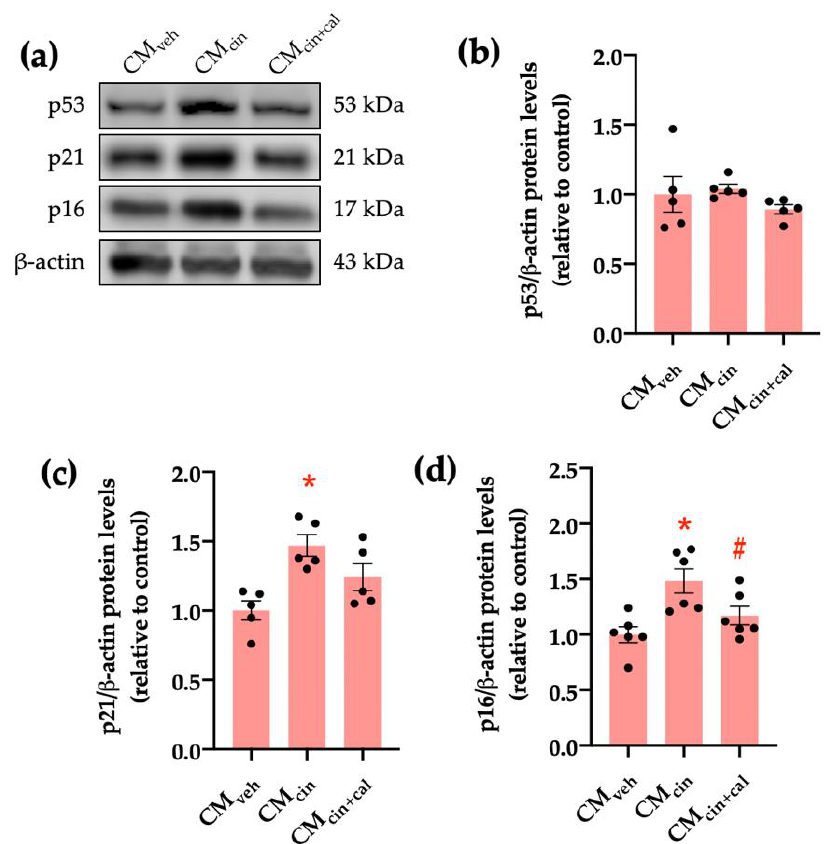
Figure 2. CaSR activation in SW872 pre-adipocytes induces the secretion of factors that activate the p16/p21/p53 cascade in HepG2 cells: ( a ) immunodetection of p53, p21, and p16 protein levels in HepG2 cells exposed to the CM veh , CM cin , and CM cin+cal ; ( b ) quantification of p53 protein levels; ( c ) quantification of p21 protein levels; ( d ) quantification of p16 protein levels. Each dot represents an individual experiment (n = 5–6). * p < 0.05, versus the control, # p < 0.05 versus CM cin , Friedman’s test, and Dunn’s post-hoc test.